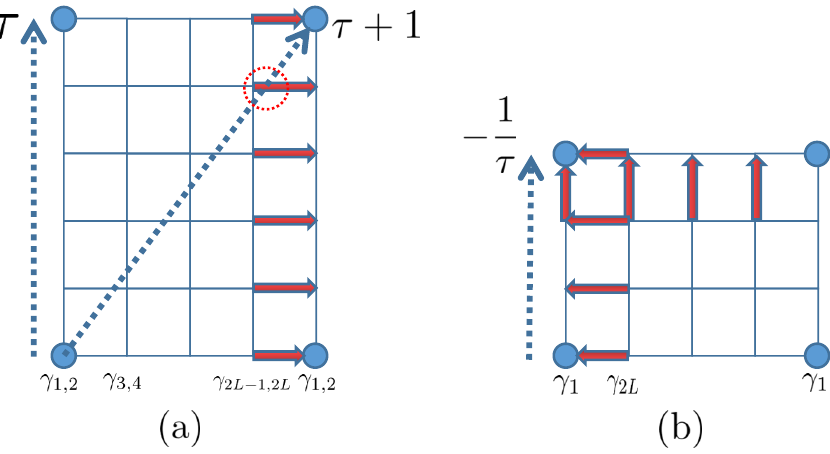
Figure 2 . (a) T transformation of spacetime torus: the transformation τ → τ + 1 crosses an additional branch cut during the continuum limit a 0 , β 0 → 0 . (b) S transformation: the space-time plane is effectively rotated by 90 degrees, after which the branch-cutting link along the spatial direction is